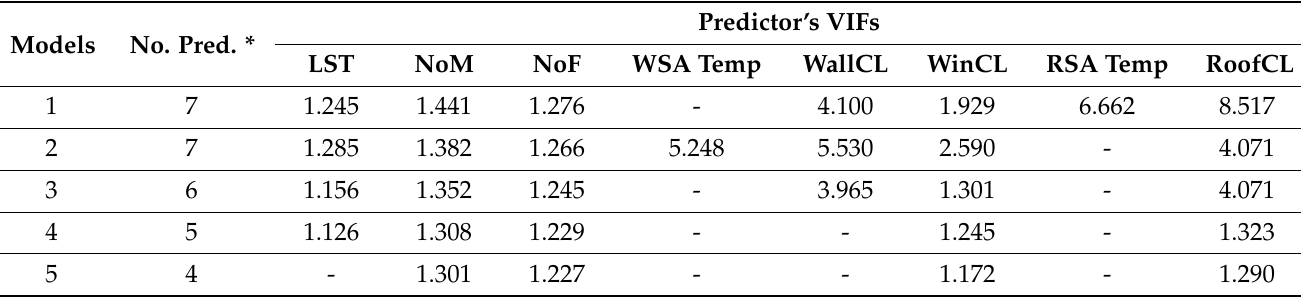
Table 1. Variance inflation factors (VIF) for selected model predictors.